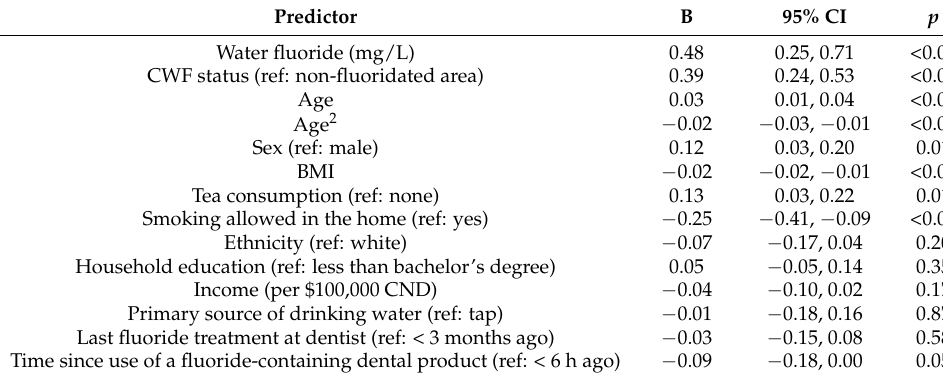
Table 3. Linear regression predicting UF SG